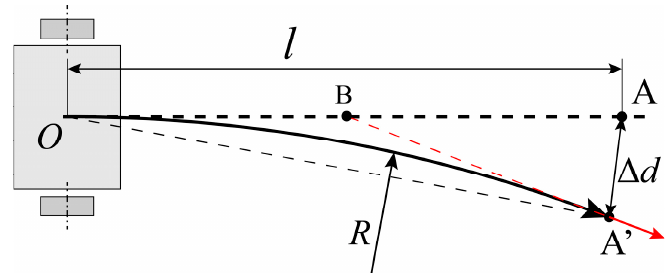
Figure 13. Destination offset caused by arc-shaped trajectory.